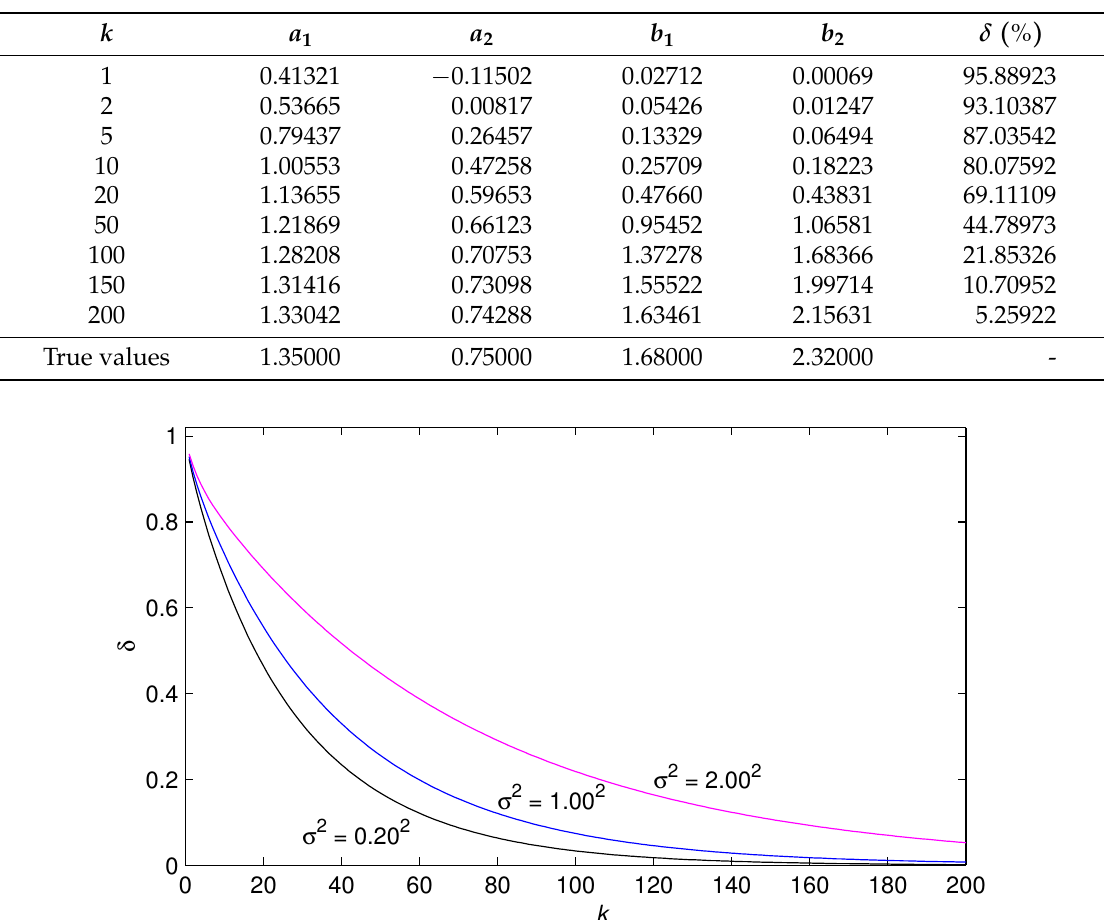
Table 4. The GI estimates and their errors with σ 2 = 2.00 2 .